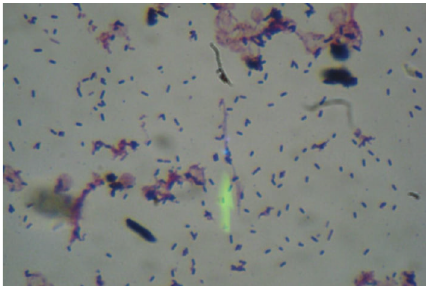
Figure 2: Gram stain from the positive blood culture. Numerous gram-positive rods in palisades and